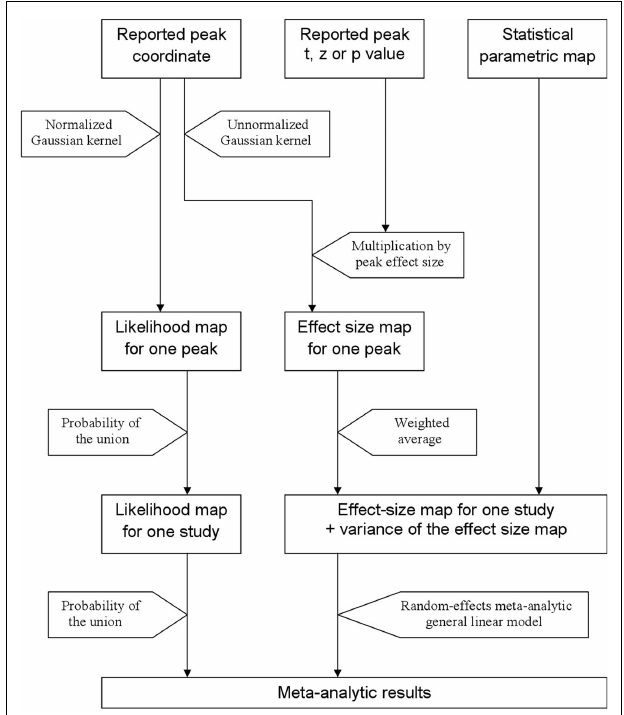
FIGURE 1 | Main steps of activation likelihood estimation (ALE) and effect-size signed differential mapping (ES-SDM) . ALE (left approach) aims to estimate the likelihood that a peak lies in any given voxel.To this end, it first applies a Gaussian kernel so that the likelihood is high in the voxel where the peak is reported and similar but slightly lower in the close voxels. Afterward, it calculates the probability of the union of the likelihoods estimated from the different peaks and studies. ES-SDM algorithms (middle and right approach) are different, as this method aims to estimate the effect size rather than the peak likelihood. However, the first step also consists in applying an (un-normalized) Gaussian kernel, this time to achieve that voxels around a reported peak have an estimated effect size which is similar but slightly smaller to that of the peak. Afterward, effect-sizes recreated from the different peaks of a study are combined using a weighted average, i.e., when a voxel is close to two peaks, it has an effect size that depends on both peaks. Finally, the effect size maps as well as their variance maps are introduced in a meta-analytic random-effects general linear